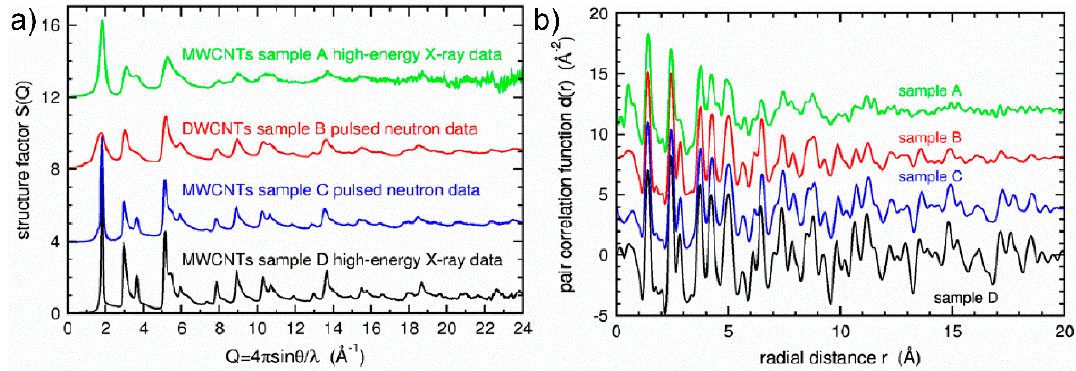
Figure 35. ( a ) Comparison of the structure factors for the sample A (MWCNTs obtained by template deposition), the sample B and C (catalytic DWCNTs and MWCNTs), and the sample D (MWCNTs obtained by arc discharge). ( b ) The pair distribution functions computed from the data shown on ( a ). Reproduced with permission from Hawelek et al. [119]. Copyright Elsevier, 2012.